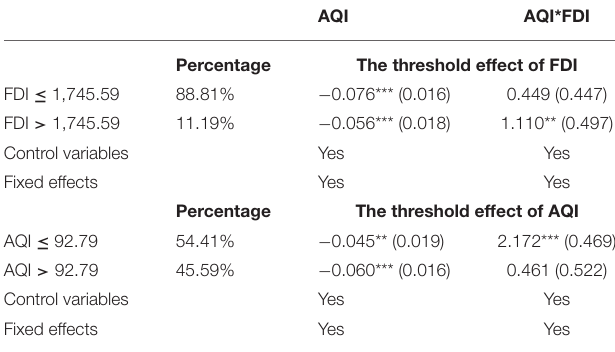
TABLE 9 | Regression results of the threshold